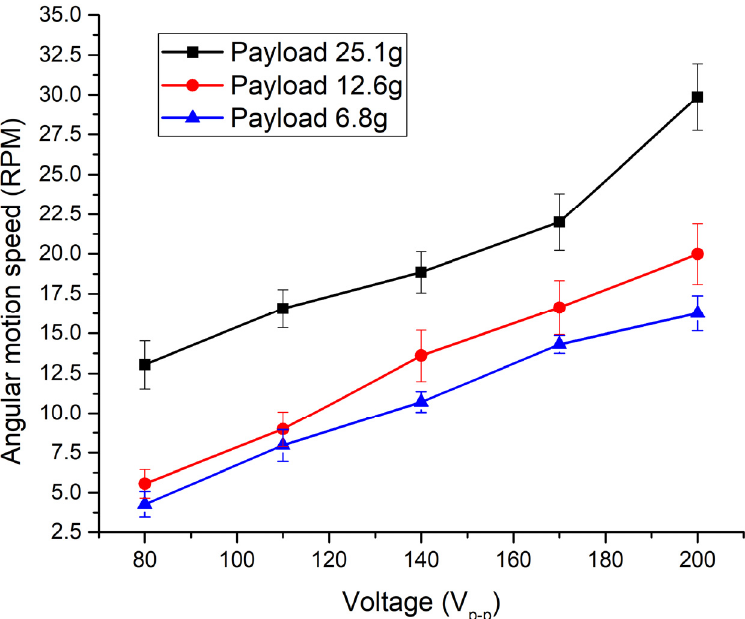
Figure 18. Dependence of angular velocity from excitation voltage when different payloads are ap- plied.